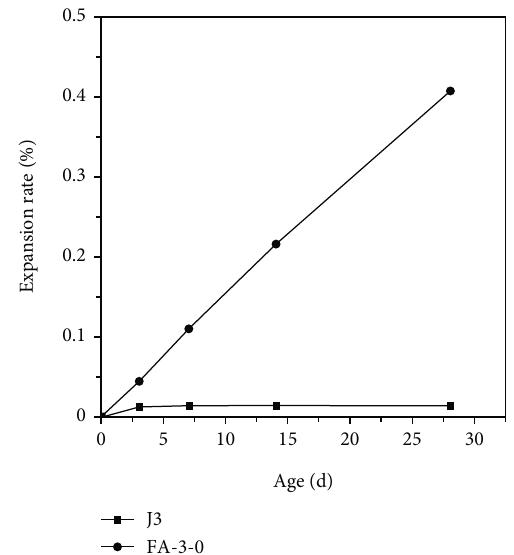
Figure 8: The diagram between FA-5-0 benchmark specimen and